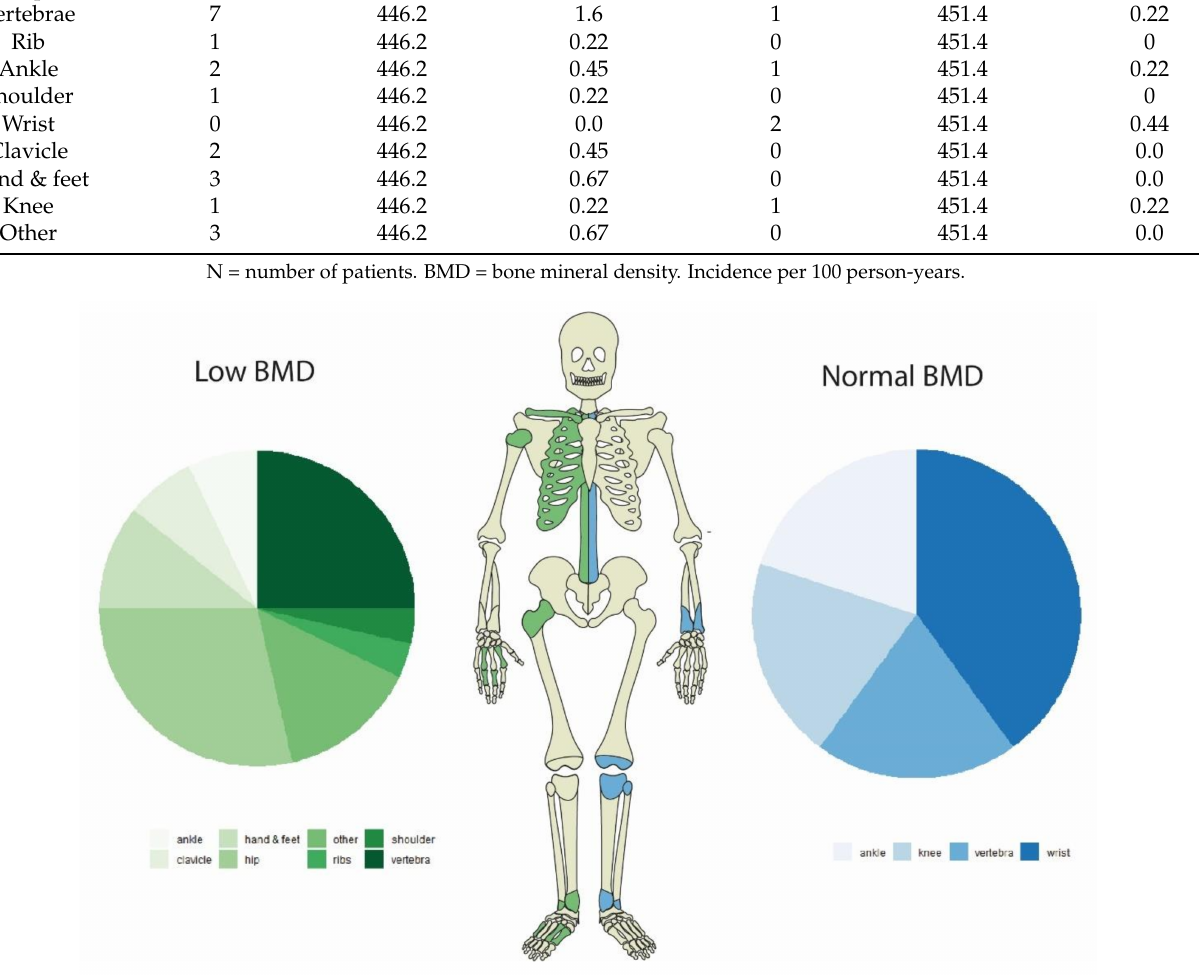
Figure 2. Distribution of fractures by bone mineral density (BMD). Fractures in both groups were evenly distributed among body regions, with hip, vertebra and wrist fractures being more prominent